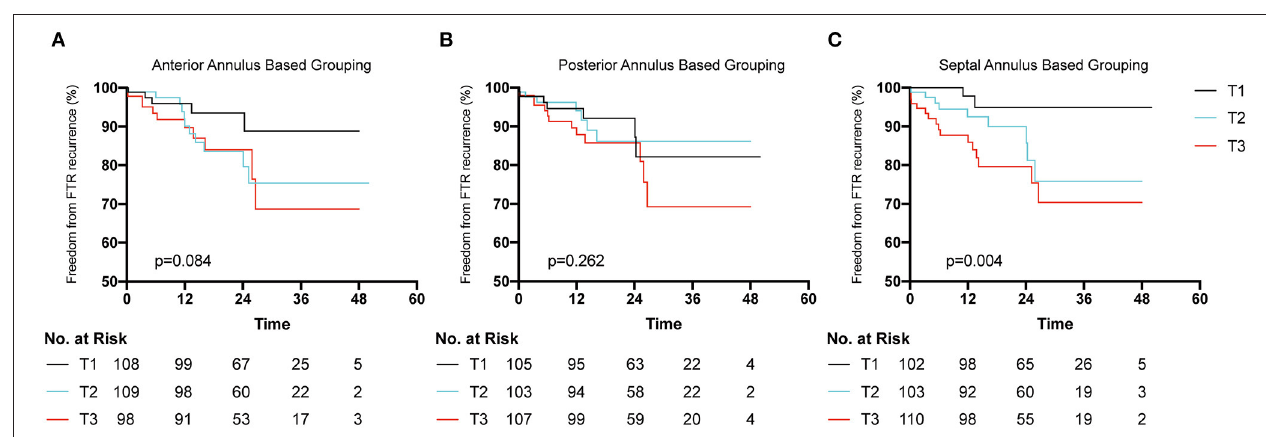
FIGURE 3 | Freedom from postoperative functional tricuspid regurgitation (FTR) recurrence according to the length of each segment of tricuspid annulus. Patients were grouped into tertiles (T1 shortest length and T3 longest length). (A) Patients were trisected based on the length of anterior annulus. (B) Patients were trisected based on the length of posterior annulus. (C) Patients were trisected grouped based on the length of septal annulus.